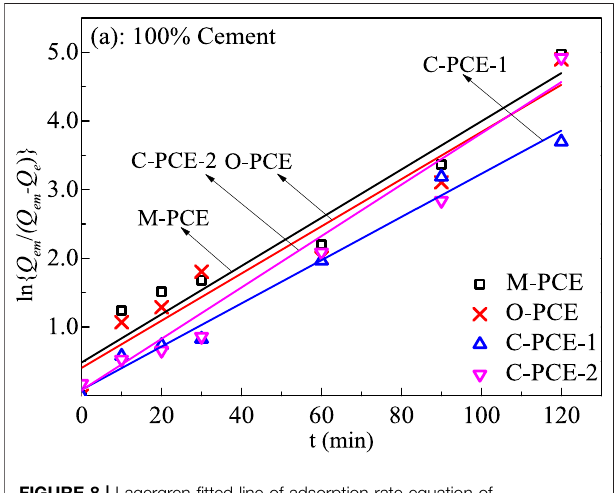
FIGURE 6 | Adsorption amount of polycarboxylate molecules on the surface of Portland cement at 20 ° C (0.2% dosage).